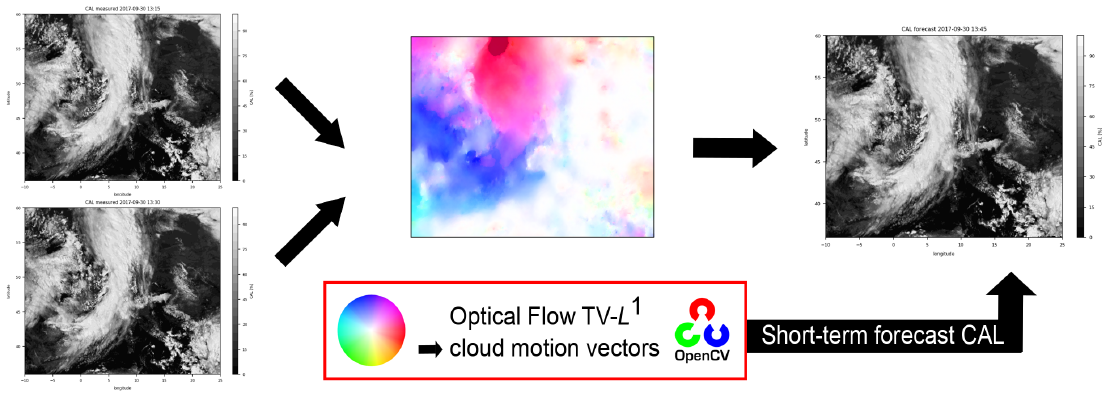
Figure 1. Scheme of the optical flow method TV- L 1 (Method based on total variation in the regularization term and the L 1 -norm in the data fidelity term). Two subsequent images of the effective cloud albedo represent the input of the algorithm. The calculated motion vectors are then applied to the latter of the two images to extrapolate cloud albedo (CAL) into the future. For the sake of clarity the motion vectors are displayed with the help of the HSV (hue saturation value) color